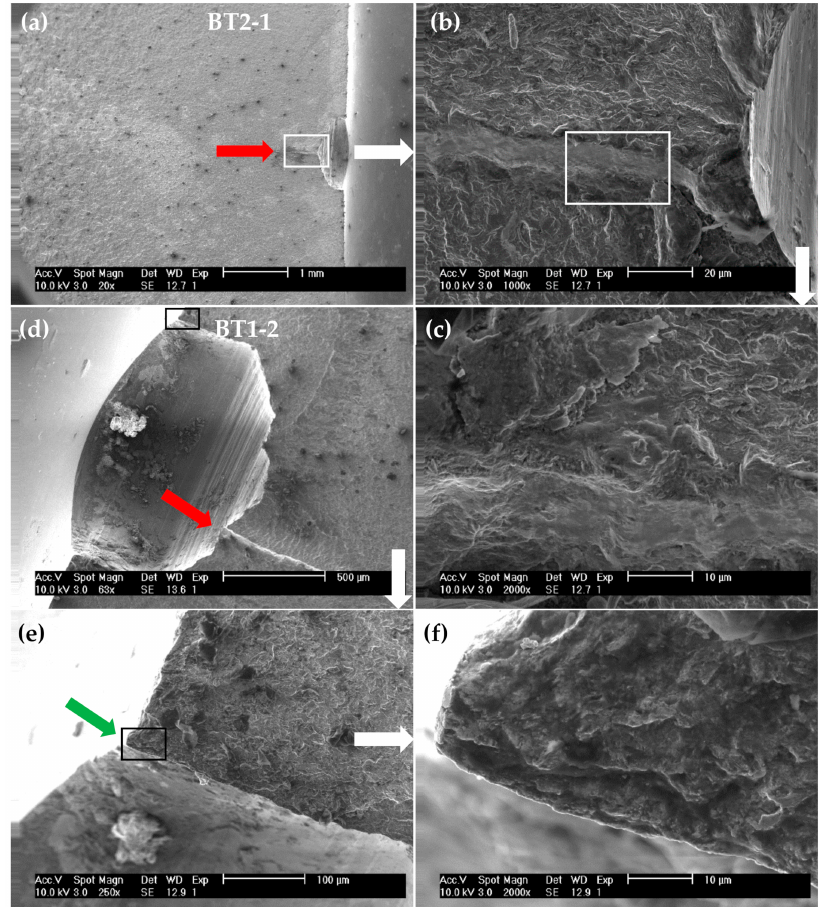
Figure 5. SEM micrographs of the BT2-1 ( a – c ) and the BT1-2 ( d – f )